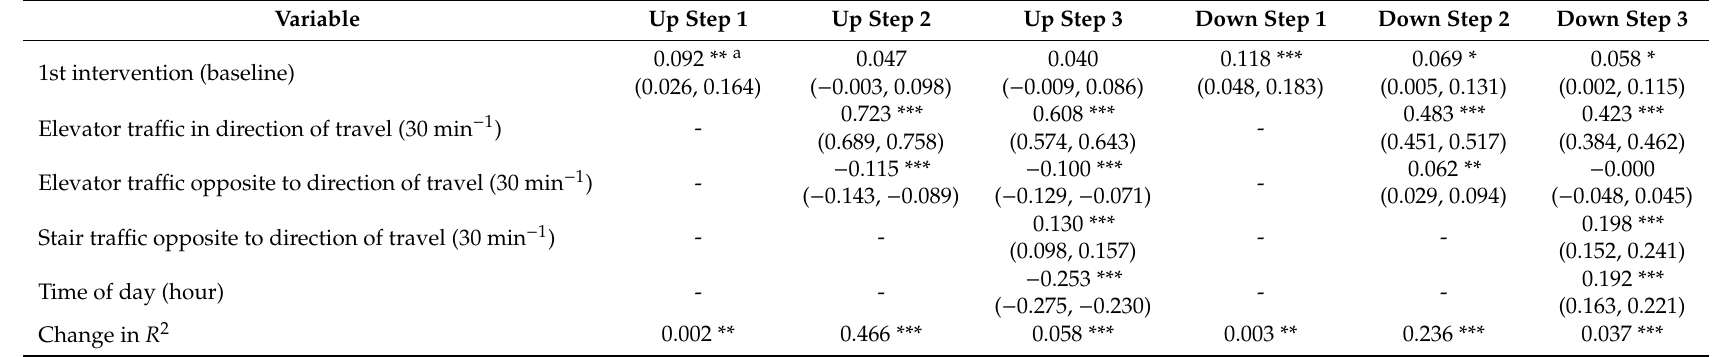
Table 5. Summary of the e ff ects of variables on stair use in Barcelona during the first intervention phase.